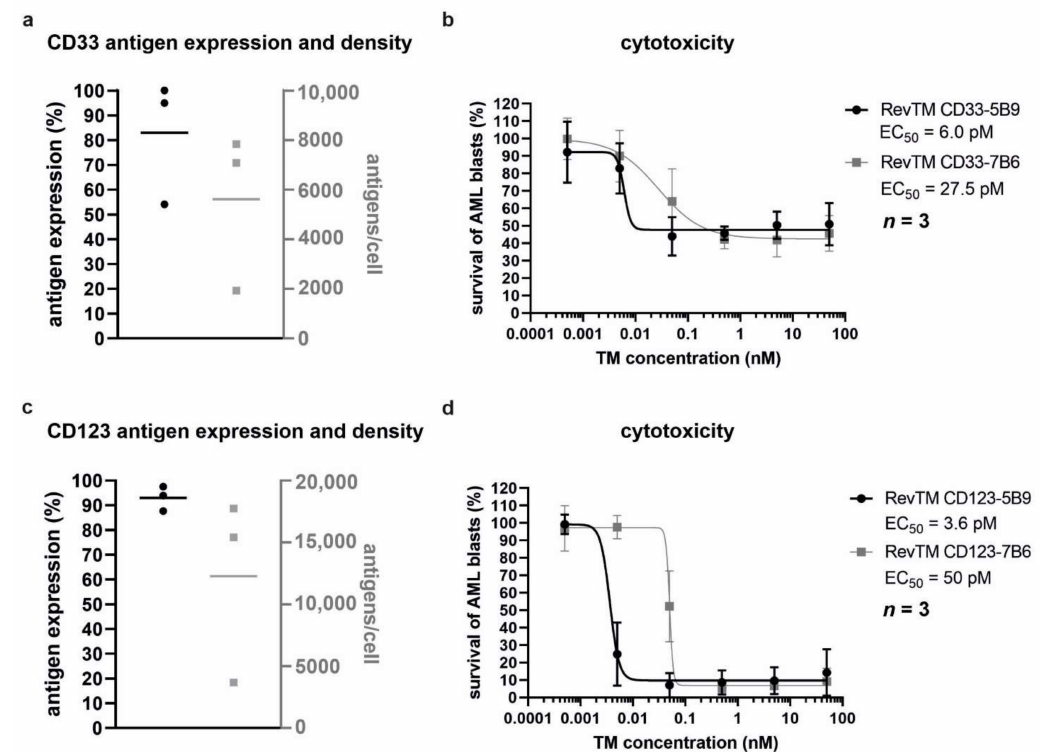
Figure 6. Killing of patient-derived AML blasts by redirected RevCAR T-cells. Expression of ( a ) CD33 and ( c ) CD123 on AML blasts from three patients was assessed by flow cytometry after staining with anti-CD33 and anti-CD123 com- mercial mAbs. Number of tumor-associated antigens ( a ) CD33 or ( c ) CD123 on the surface of patient-derived AML blasts was determined using QiFi kit. ( b , d ) RevCAR-E5B9-28/3z or RevCAR-E7B6-28/3z T-cells were co-cultured with the eFluor ™ 670-stained patient-derived AML blasts at a ratio of 1:1 in the presence of indicated RevTMs with increasing concentrations in a flow cytometry-based assay, in which the number of living AML blasts was determined. Based on the resulting dose–response curves, half-maximal effective concentration (EC 50 ) values were calculated. Data represents three individual T-cell donors and three individual patient-derived AML blasts as mean ±